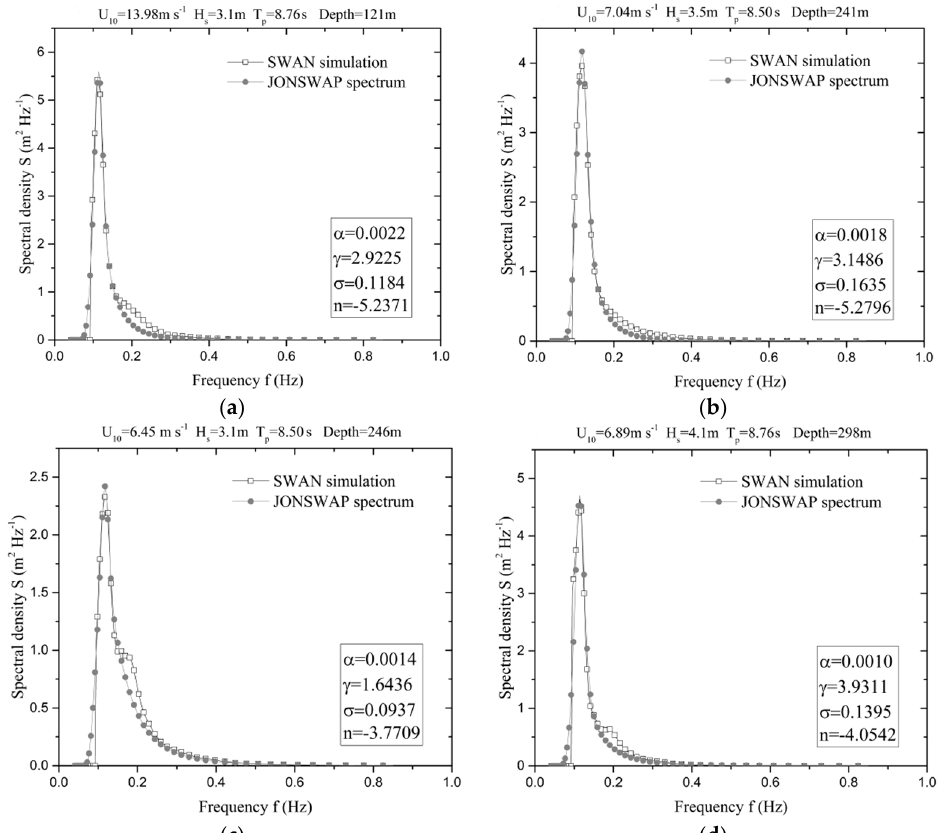
Figure 5. The comparison between wave spectra generated by SWAN simulation and calculations according to the JONSWAP spectrum model (with best-fitted parameters). Water depth: ( a ) 121 m; ( b ) 241 m; ( c ) 246 m; and ( d ) 298 m.